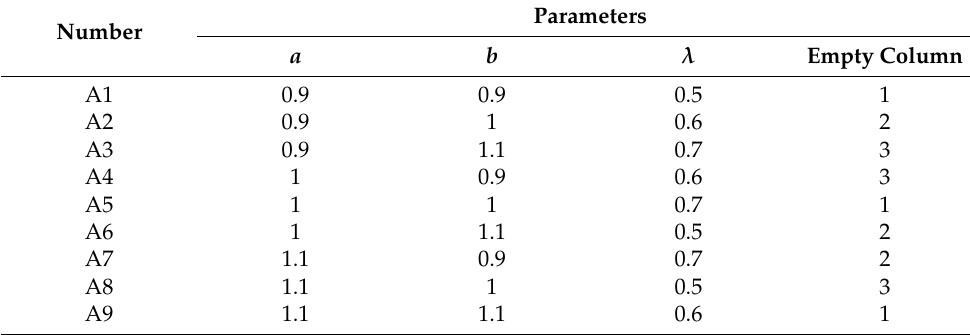
Table 3. Orthogonal test scheme.